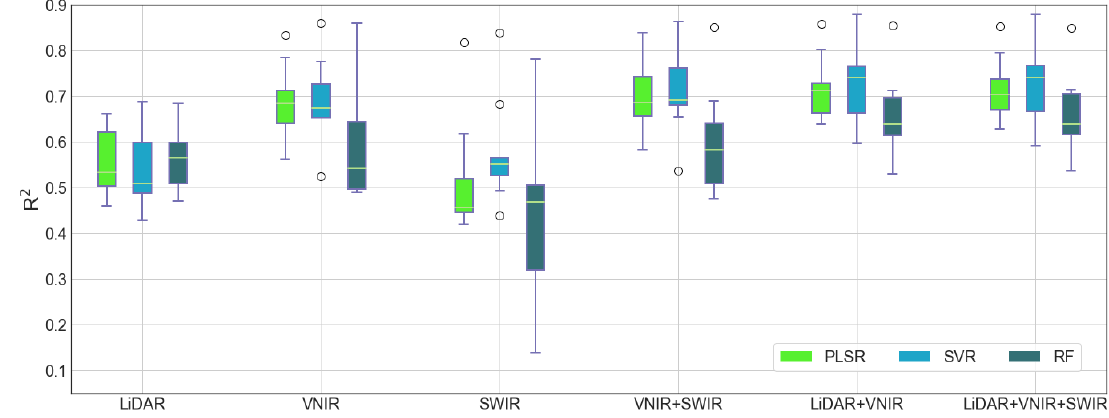
Figure 24. Box plot of the prediction results for various data sources and regression methods.